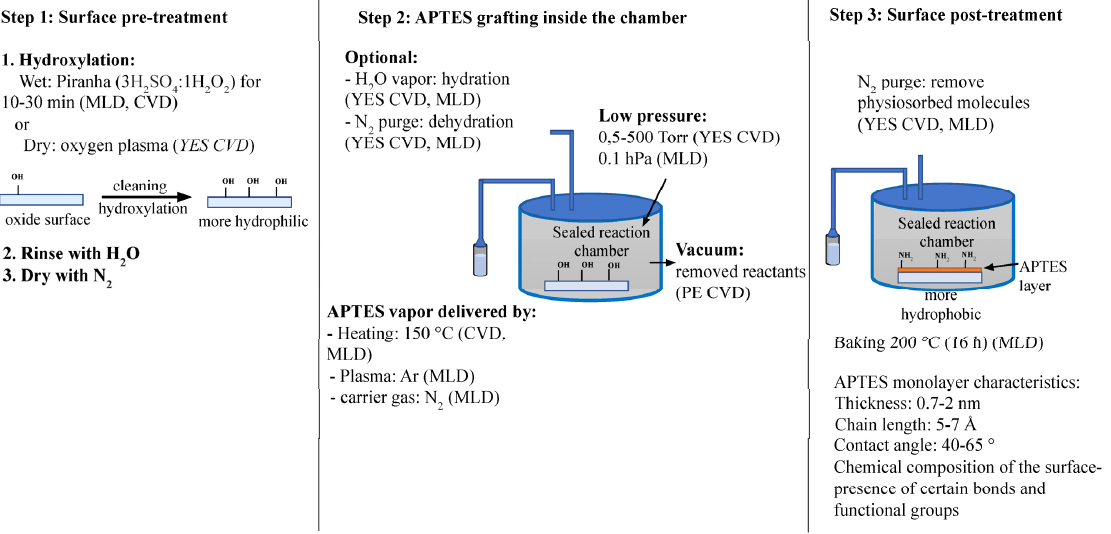
Figure 3. Vapor-phase APTES grafting on plain oxide surfaces. A general guideline for producing APTES monolayers.